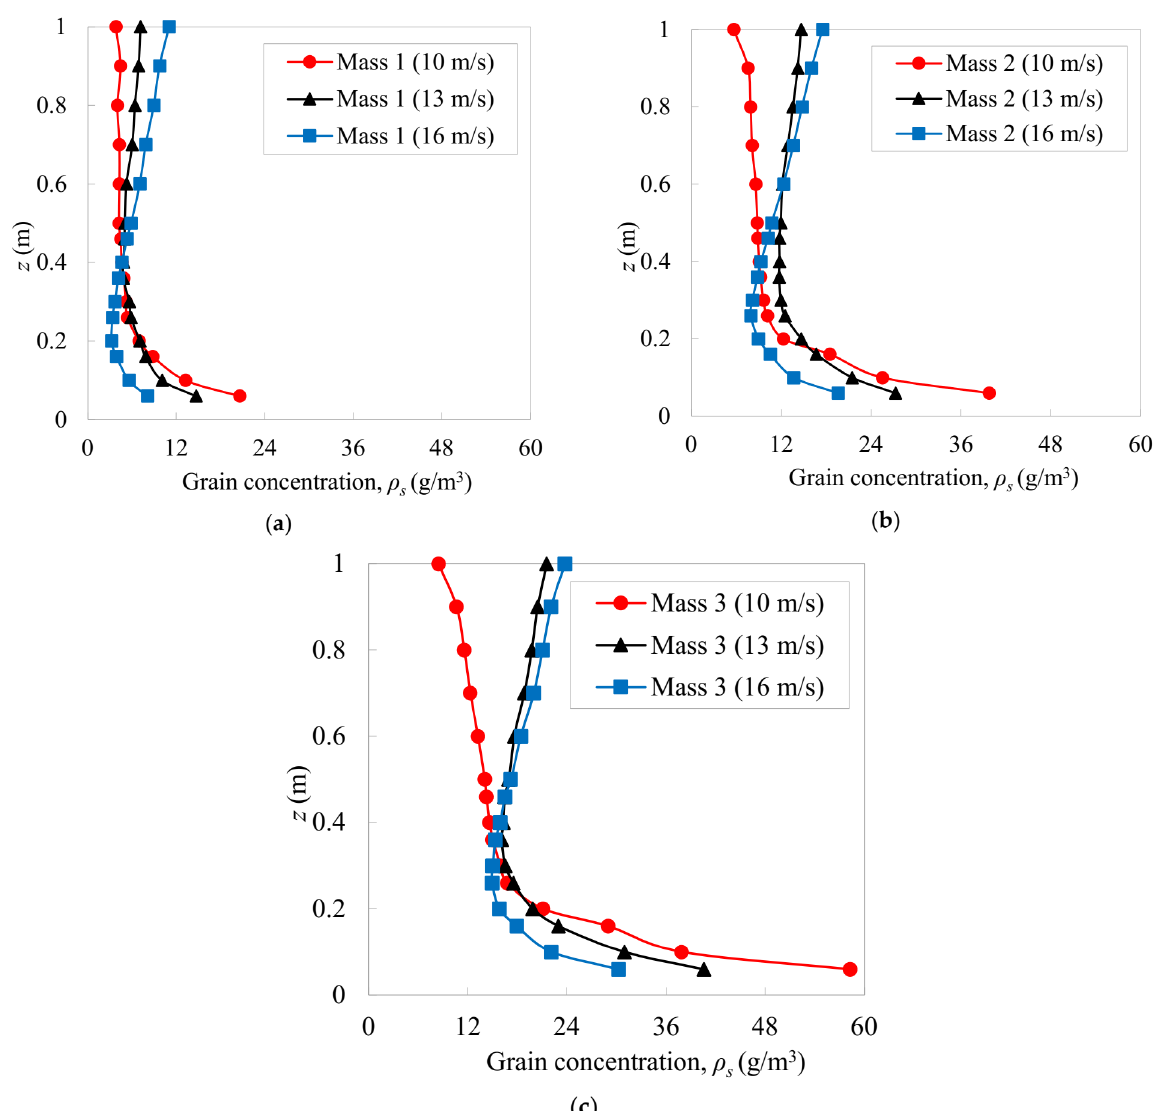
Figure 6. Grain concentration profiles at three kinds of sand grain mass: ( a ) Mass 1; ( b ) Mass 2; ( c ) Mass